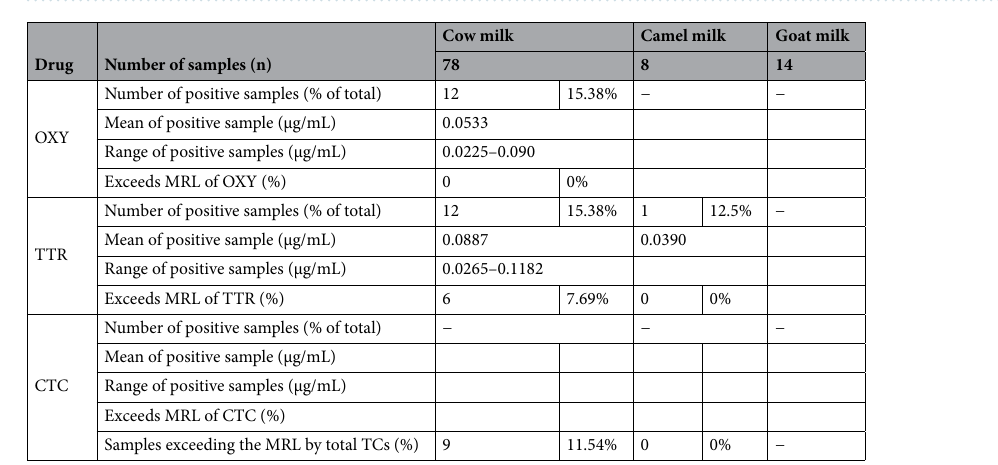
Figure 8. Schematic diagram of the workflow.